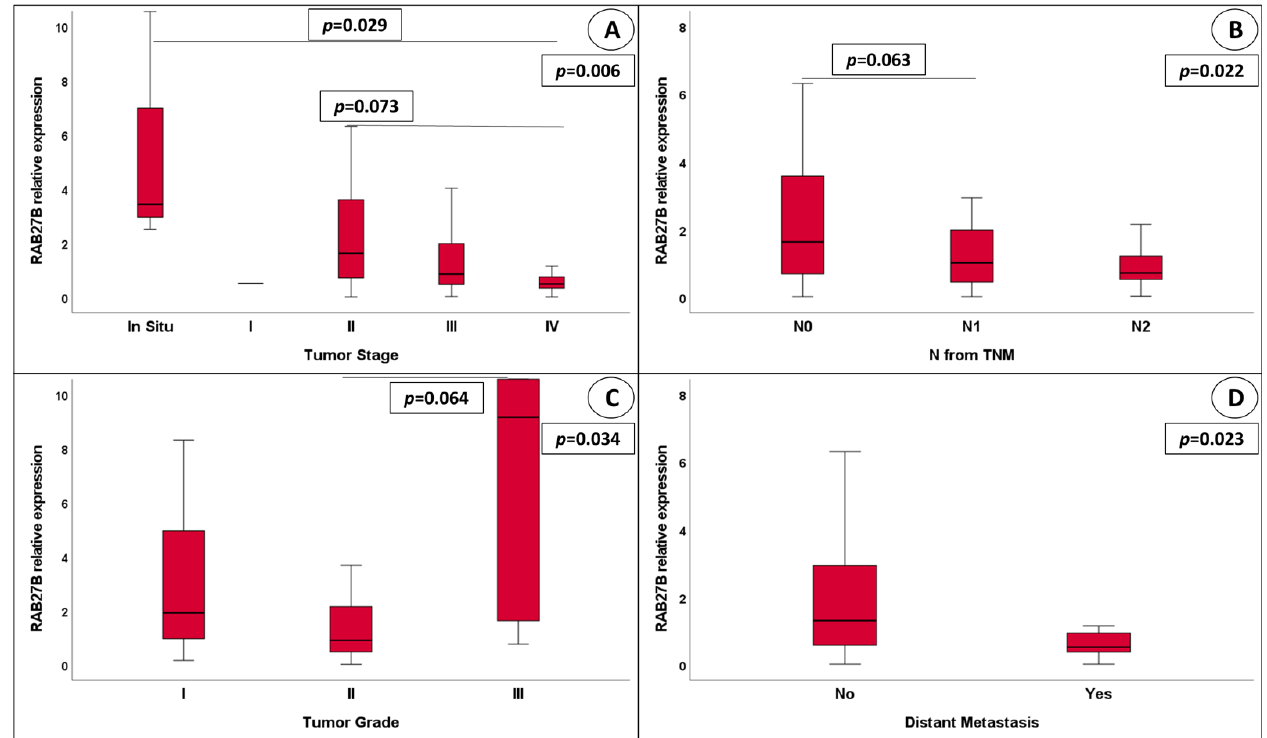
Figure 2. Relative gene expression of ( A ) RAB27B with regards to disease stage, ( B ) RAB27B with regards to lymph node infiltration, ( C ) RAB27B with regards to tumor grade and ( D ) RAB27B with regards to metastatic status in our CRC patients’ cohort (n = 109). Relative RAB27B expression is decreasing as disease stage increases, with tumor with lymph node infiltration and distant metastases having lower RAB27B expression. RAB27B expression is higher in grade III tumors compared to grade II tumors.